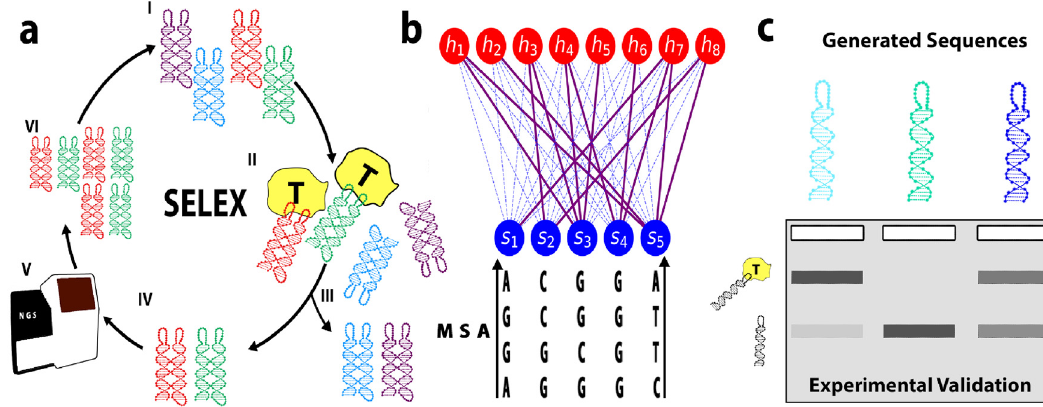
Fig 1. Schematic view of the SELEX experiment and the RBM-based analysis. a : The SELEX procedure used to obtain DNA aptamers that bind to thrombin consists of the following steps: I) We start with an initial library of DNA sequences. II) DNA aptamers compete with each other to bind to thrombin. III) Sequences that are unbound (or bound too weakly) are washed away. IV) Remaining bound sequences dissociate after the sample is heated up. V) Binding sequences are sequenced. VI) Using polymerase chain reaction (PCR), multiple copies are made of the remaining sequences, resulting into a new library of aptamers for the next round of selection. b : The sequenced aptamers from respective rounds of the SELEX protocol are used to train the parameters of the Restricted Boltzmann Machine model. In this unsupervised neural network architecture, a layer of visible units carry the aptamer sequence, while the layer of hidden units extract representations. The weighted connections between the two layers are learned through maximization of the log-likelihood of the sequences obtained through SELEX. c : Single loop sequences generated using the Restricted Boltzmann Machine model are experimentally validated using gel assays.